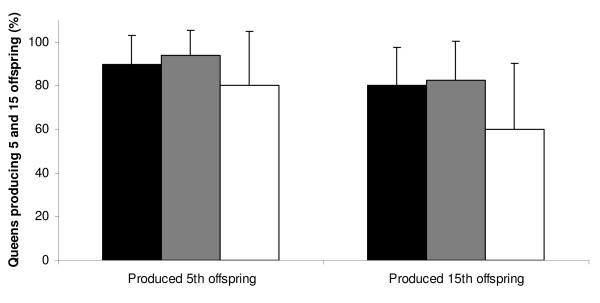
The percentage of queens producing 5 and 15 offspring according to treatment. Black bars represent the outbred treatment, grey bars the inbred treatment and white bars the diploid male treatment. No significant difference was found between these values (P = 0.835 for 5 offspring & P = 0.248 for 15 offspring). Sample size within each treatment ranged from 6 to 18 and error bars show 95% shortest unbiased confidence limits.